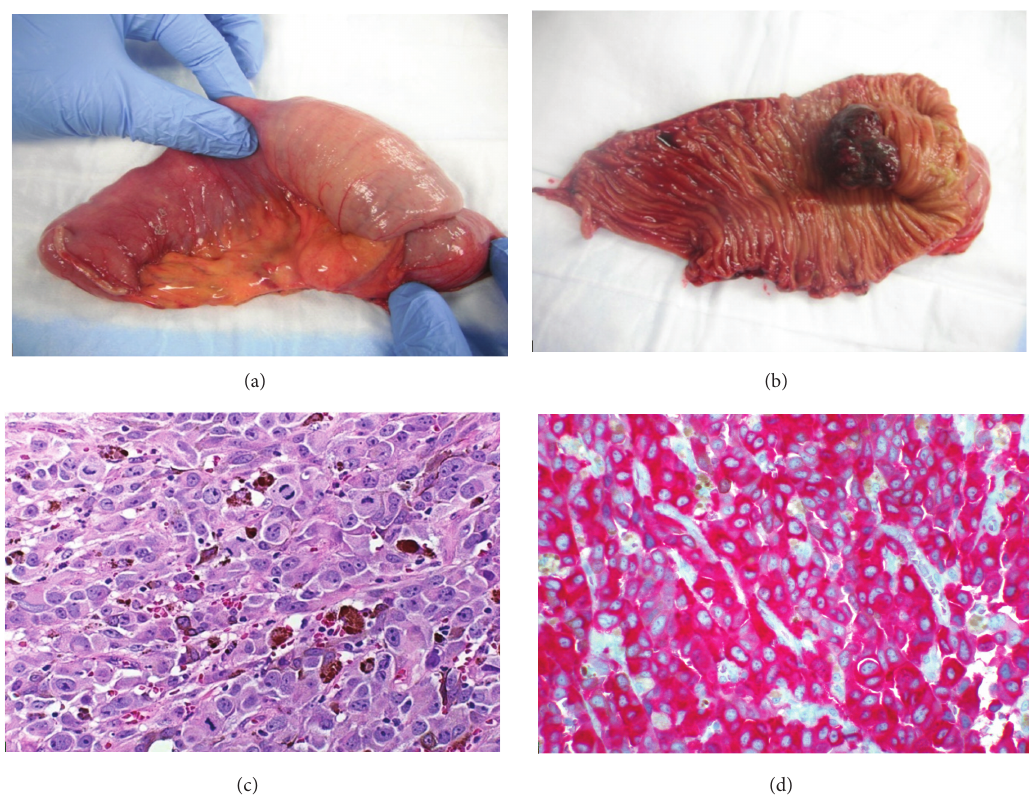
Figure 1: (a) Intussusception of the small bowel. (b) Exophytic pigmented mass. (c) Microscopic picture of the mass showing epithelioid cells with prominent nucleoli, brown pigment, and multiple mitotic figures (20hpf). (d) Tumor cells are positive for Melan A